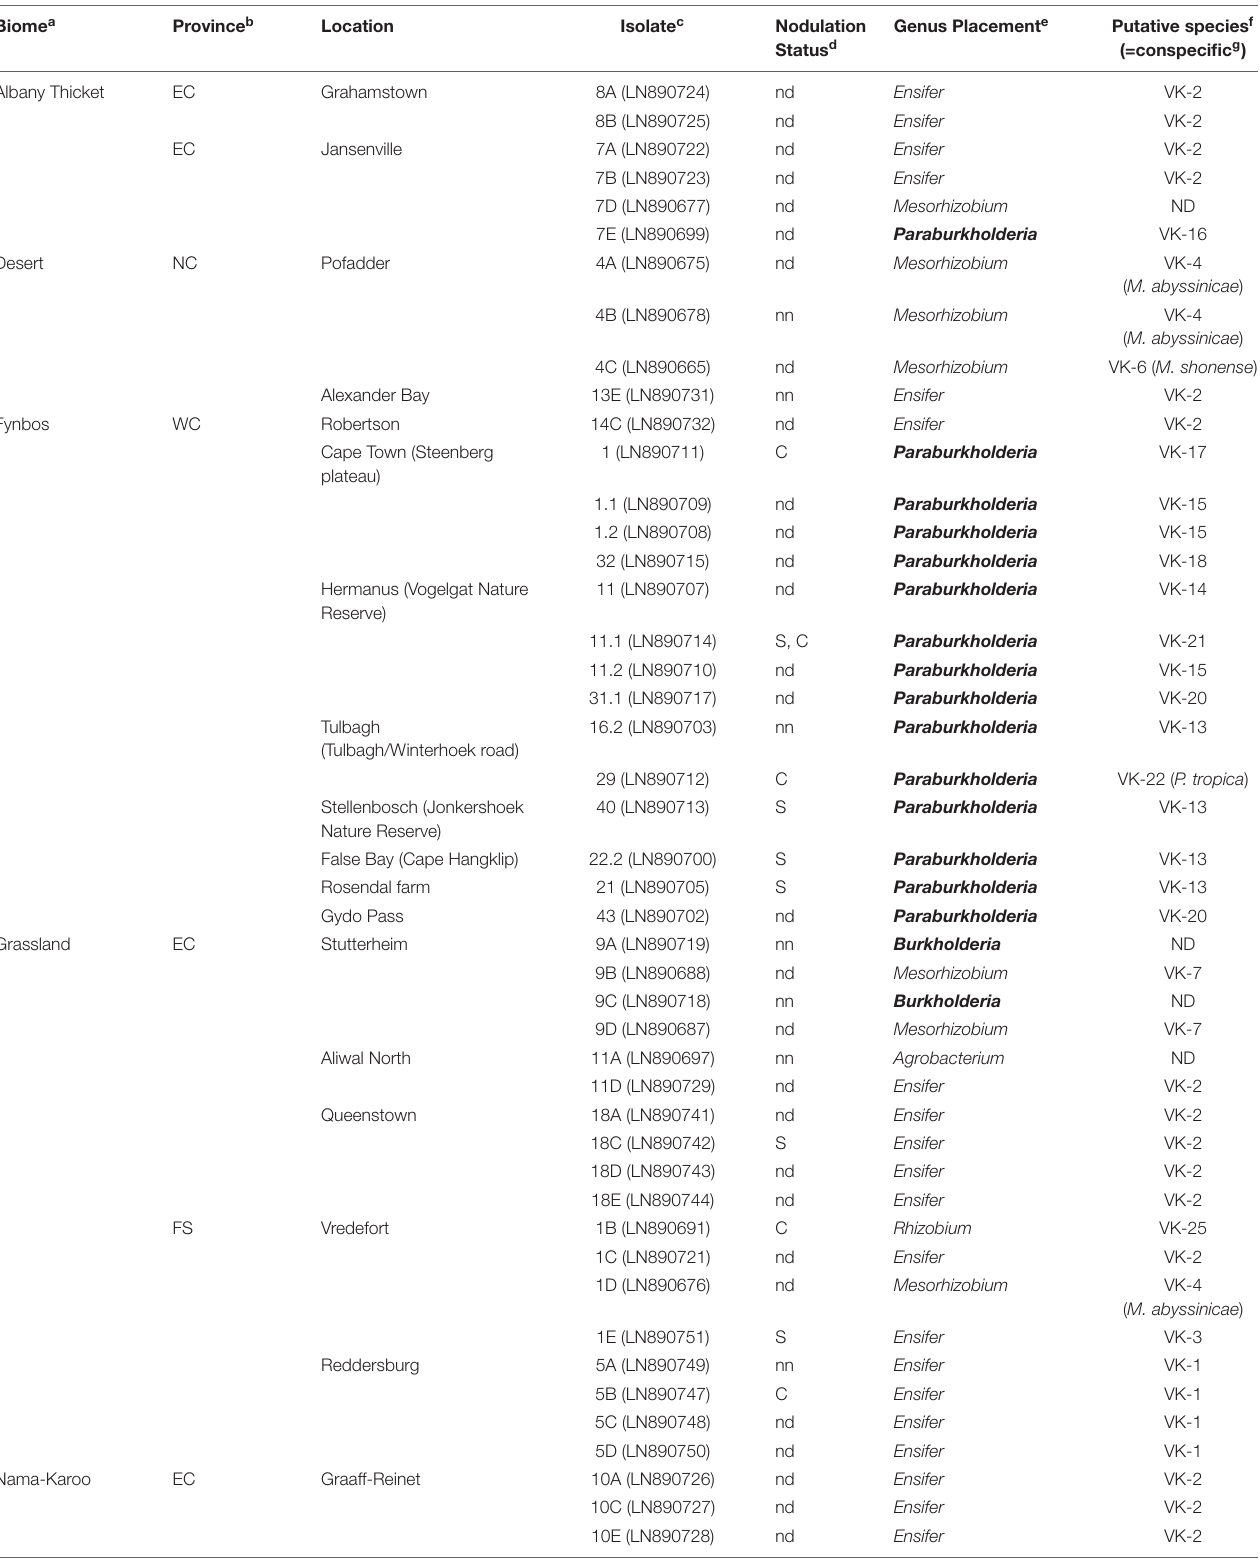
TABLE 1 | Information regarding the rhizobia associated with Vachellia karroo included in this study. Biome